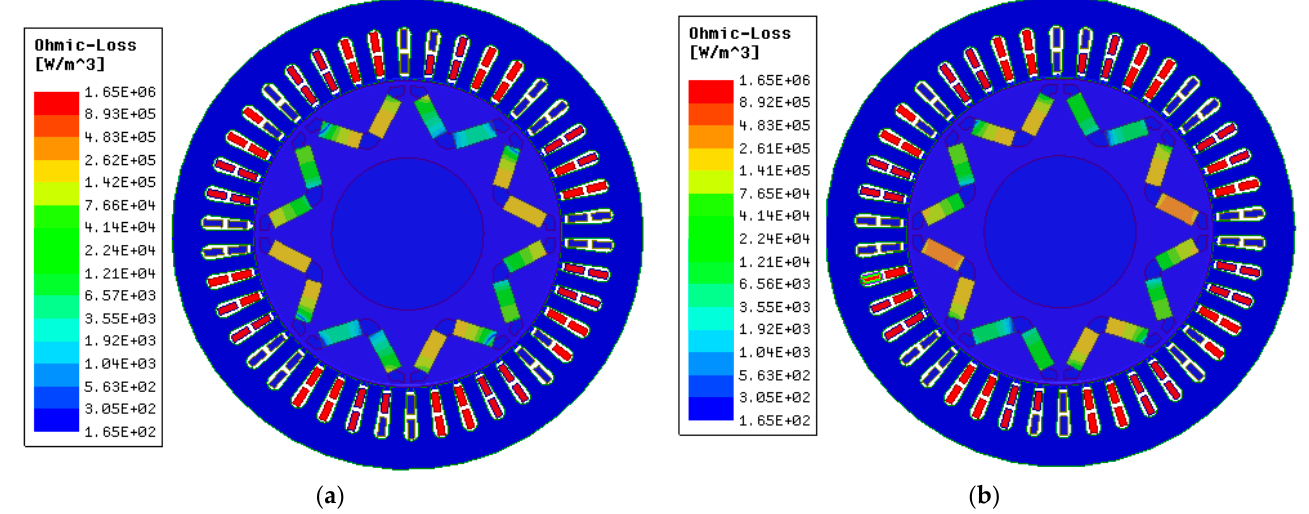
Figure 15. Ohmic-loss. ( a ) Unidirectional coupling; ( b ) bidirectional coupling.